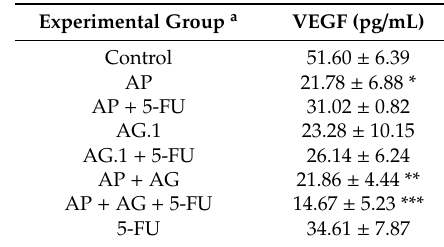
Table 5. E ff ect of treatment with Agarikon Plus, Agarikon.1 and 5-fluorouracil in various combinations on proangiogenic growth factor VEGF levels in serum supernatant of mice bearing CT26.WT